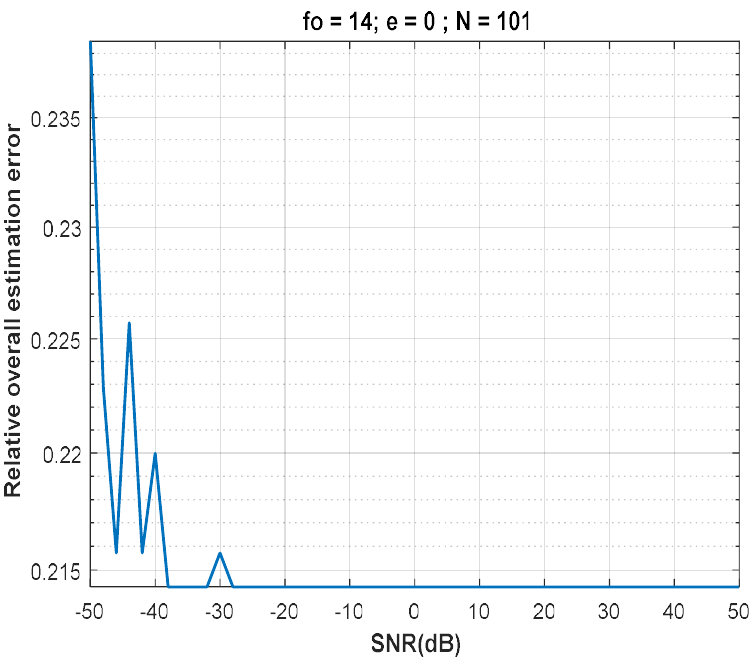
Figure 14. FE of noisy single tone signals by DNN.